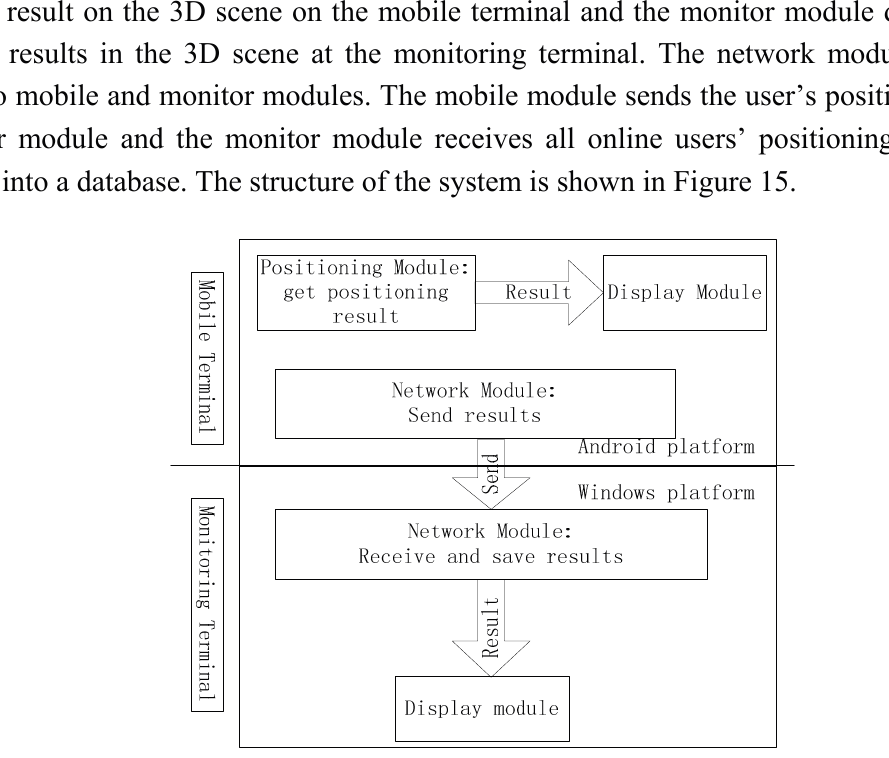
Figure 15. Structure of the 3D indoor positioning